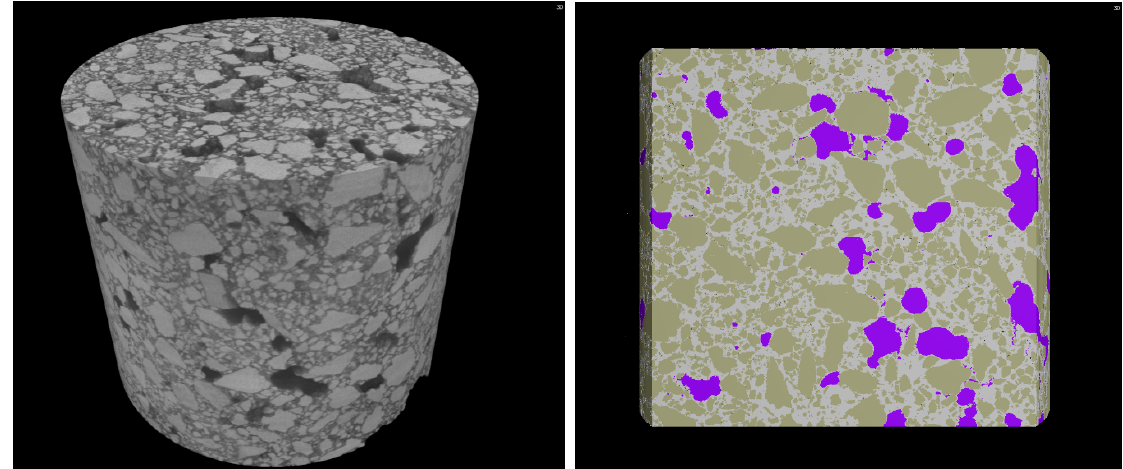
Figure 11. Example of the 3D visualization of sample NM. On the left , the gray scale reconstruction cylinder is visible. On the right , a section of the cylinder in false color is shown. The pores (violet), aggregate (light brown) and the binder (white) are highlighted. (For interpretation of the references to color in this figure the reader is referred to the web version of this article).